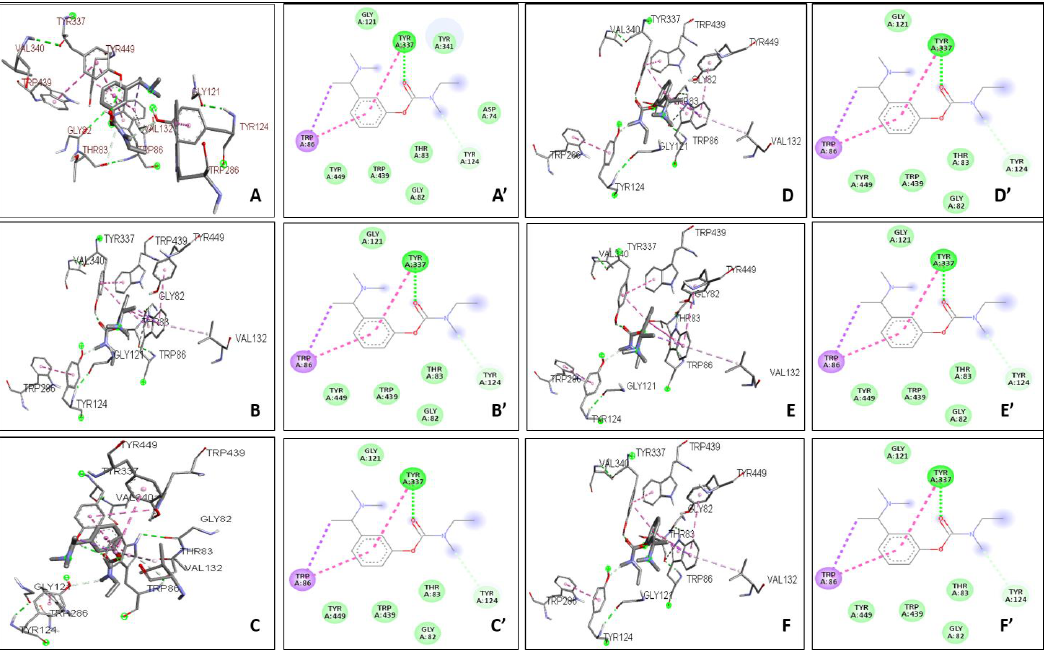
Figure 4. Interaction of Acetylcholinesterase with drugs ( A – C’ ) and compounds ( D – F’ ) ( A ) 3D interaction of Galantamine. ( A’ ) 2D interaction of Galantamine. ( B ) 3D interaction of Donepezil. ( B’ ) 2D interaction of Donepezil. ( C ) 3D interaction with Rivastigmine. ( C’ ) 2D interaction with Rivastigmine. ( D ) 3D interaction with THCV. ( D’ ) 2D interaction with THCV. ( E ) 3D interaction with Cannabinol C2. ( E’ ) 2D interaction with Cannabinol C2. ( F ) 3D interaction with Cannabidiorcol. ( F’ ) 2D interaction with Cannabidiorcol.